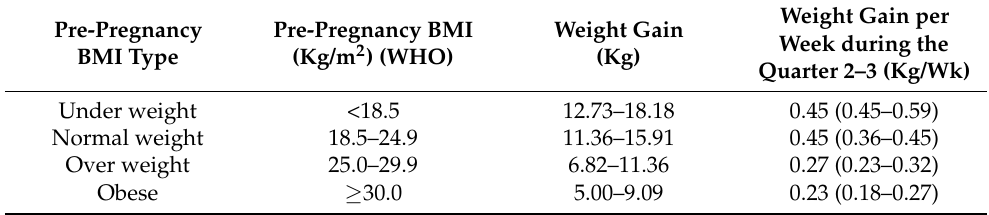
Table 2. Weight gained during pregnancy (kg) at each pregnancy stage based on pre-pregnancy BMI.